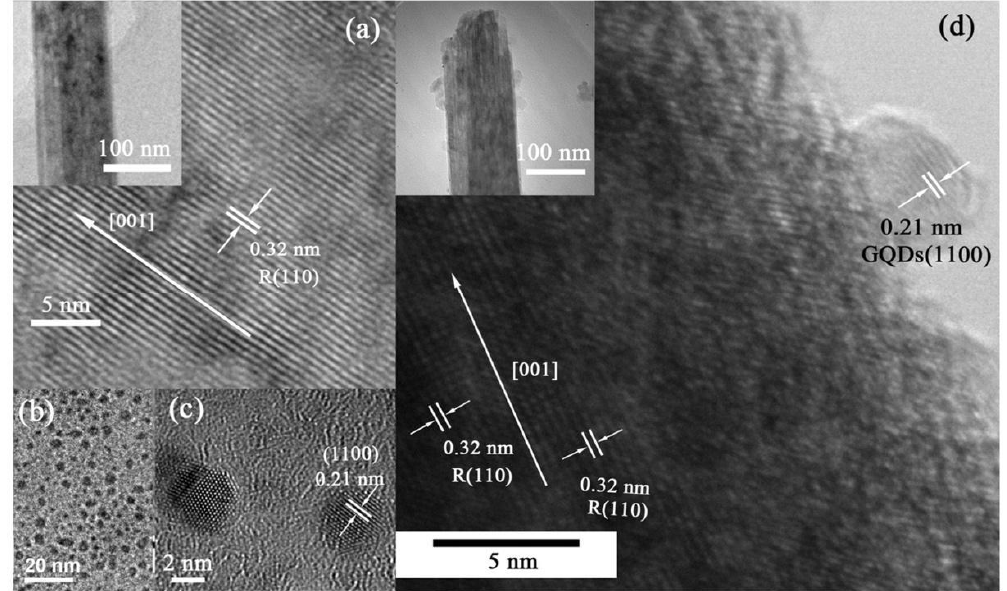
Figure 20. TEM characterization of TiO 2 NR, GQDs, and TiO 2 NR-GQDs. ( a ) HRTEM of one pristine TiO 2 nanorod. Inset is the low-magnification view. ( b ) TEM and ( c ) HRTEM images of the GQDs. ( d ) HRTEM image of TiO 2 NR-GQDs. Inset is the low-magnification view. Figure 20 reprinted with permission from [86]. Copyright 2016 IOP Science.